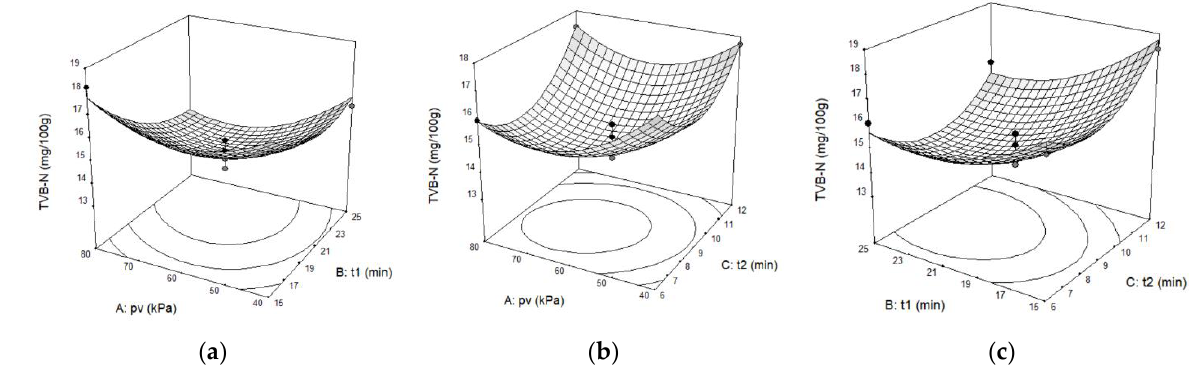
Figure 2. Three-dimensional response surface graphs for TVB-N values as a function of ( a ) p v and t 1 . ( b ) p v and t 2 . ( c ) t 1 and t 2.